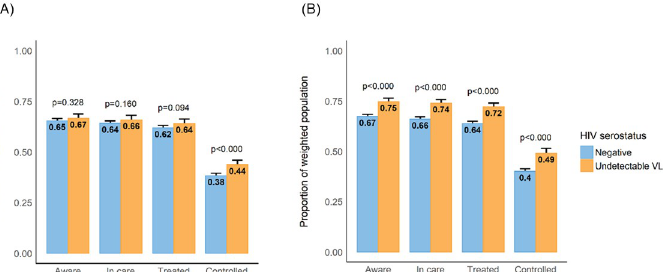
Fig 3. The cascade of hypertension care among HIV negative versus HIV positive/successful ART adults in uMkhanyakude, KwaZulu-Natal, South Africa. A. Minimally adjusted hypertension care cascade. � Estimates adjusted for age and sex only and include inverse probability of sampling weights. B. Fully adjusted hypertension care cascade. � Estimates adjusted for age, sex, BMI, education, smoking status and wealth tertile, and include inverse probability of sampling weights.